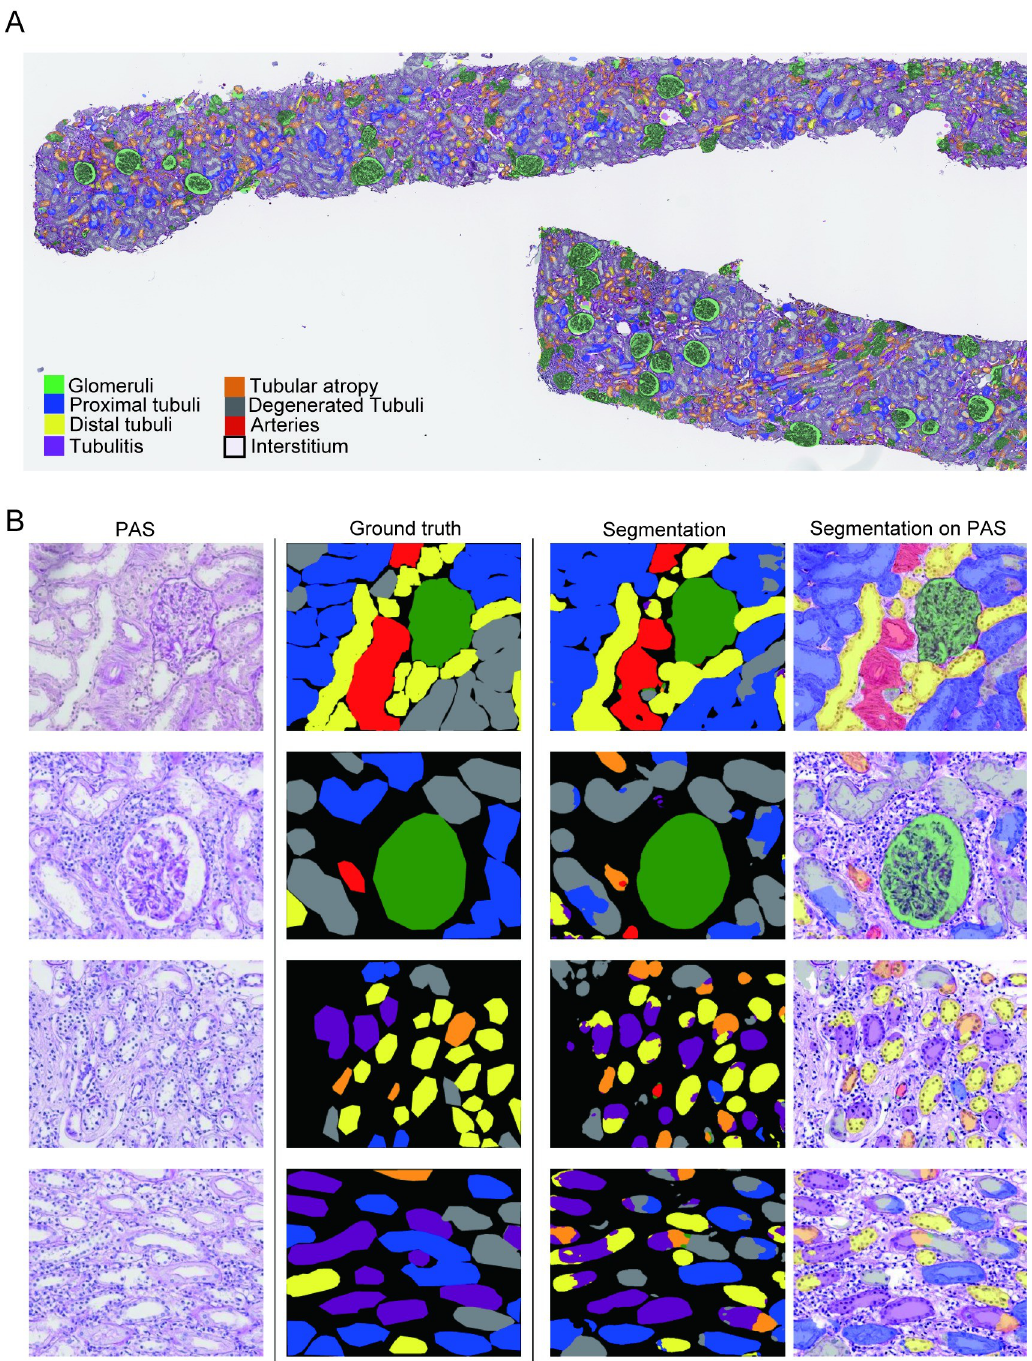
Fig 2. Representative images of ground truth and eight-class segmentation using U-Net. (A) Whole-slide image of segmentation using U-Net in a specimen with tubulointerstitial nephritis. (B) PAS-stained slide, ground truth, and segmentation using U-Net. The top row represents a normal specimen, and the second through fourth rows represent specimens with tubulointerstitial nephritis.